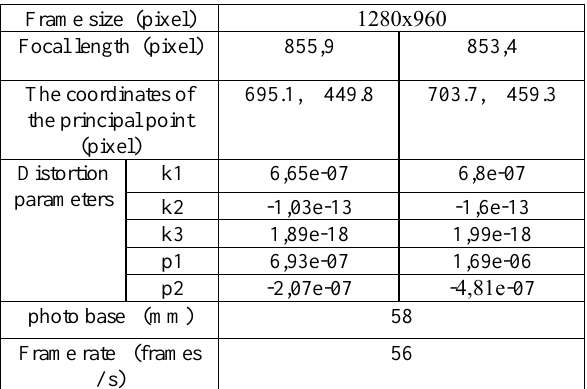
Figure. 3. Stereo camera with a photo base of 6 cm and a focal length of 5 mm